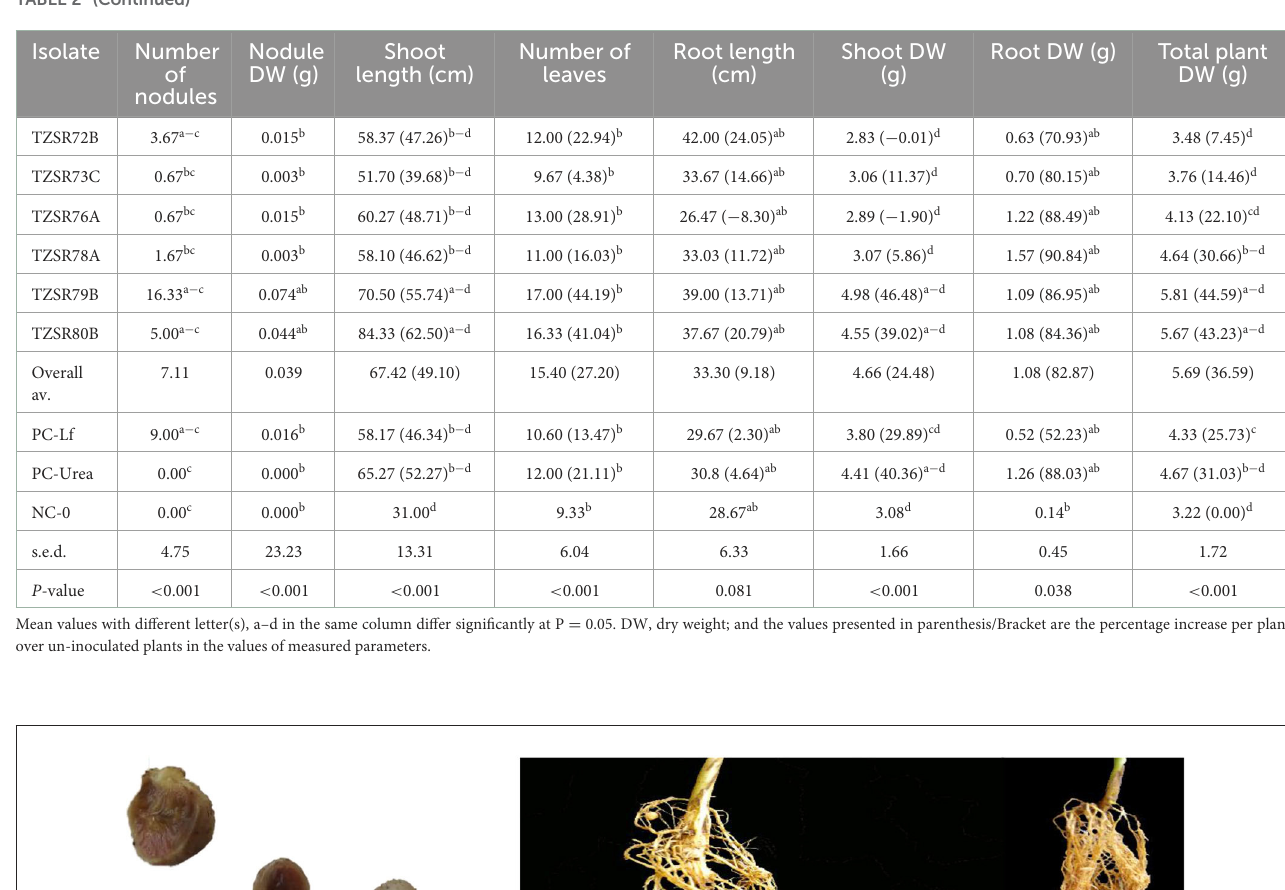
the lowest, which was 2.37 %, was recorded in those inoculated with isolate TZSR37B. Conversely, inoculation of plants with rhizobia isolates TZSR41A yielded higher averages of total and fixed N levels of 53.59 and 46.878g, respectively. The lowest level of total N (6.72 g) was recorded in the un-inoculated treatment (NC-0), whereas that of fixed N (0.15g) was recorded in plants inoculated with isolate TZSR36C. Surprisingly, the plants inoculated with isolates TZSR25A, TZSR27B, and TZSR41A that have the highest fixed N are those with the highest shoot concentration of N and total N. Among the tested, 47 rhizobia isolates, 25 equivalents to 53% isolates were highly effective in symbiosis, 18 (38%) were effective, and 4 (9%) were lowly effective in symbiosis. In addition, among the isolates which are highly effective in symbiosis, TZSR25A (245.46 %) and TZSR26B (242.40 %) were ranked high in symbiotic effectiveness (Table